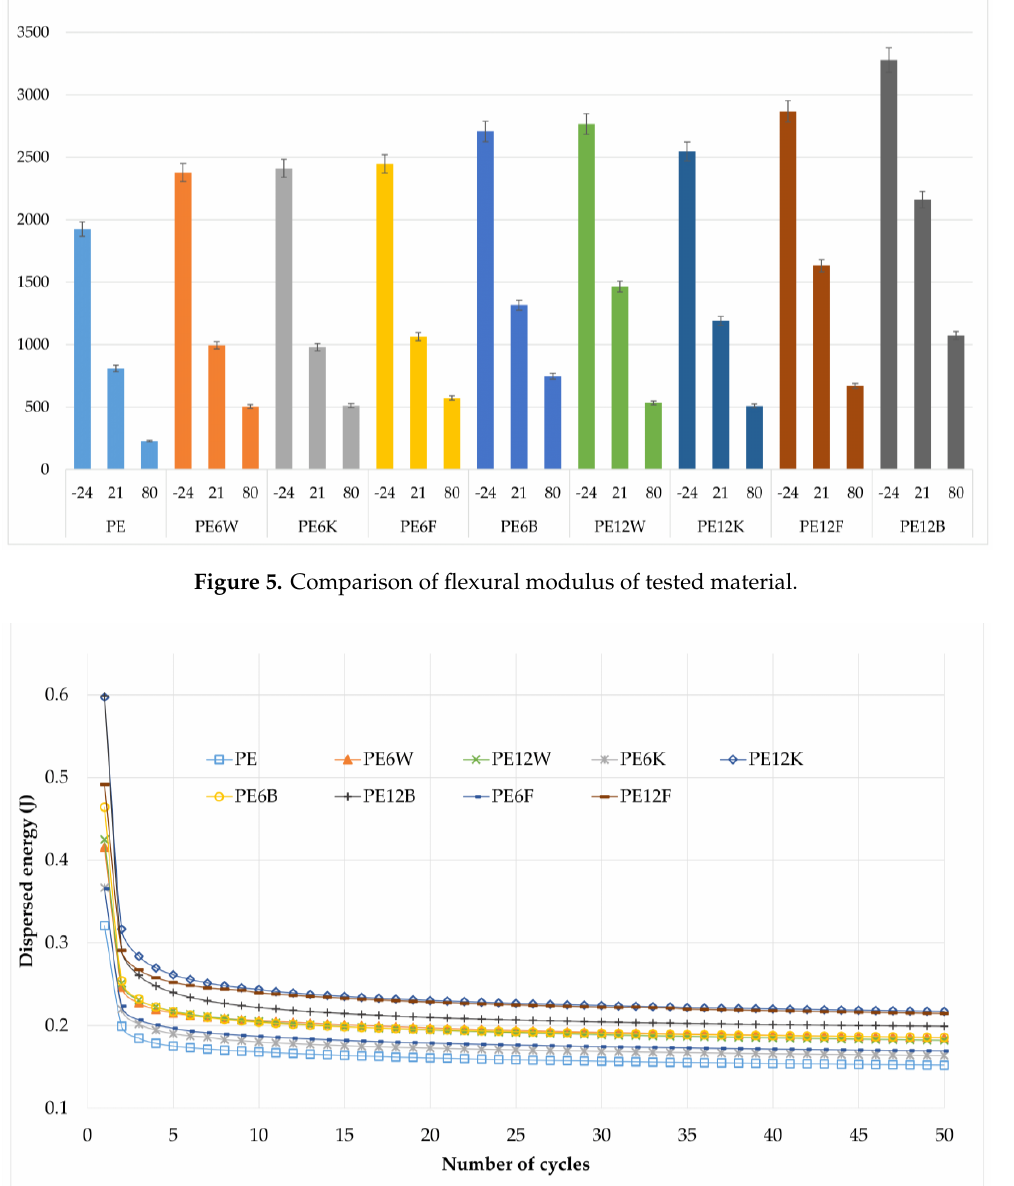
Figure 5. Comparison of flexural modulus of tested material.